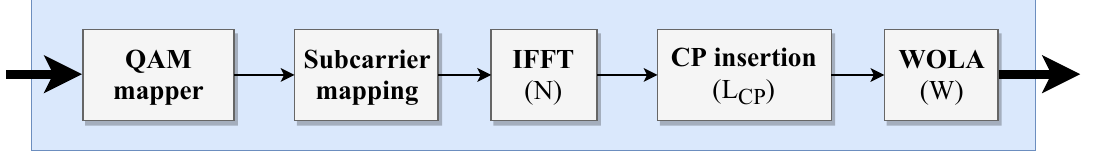
Figure 1. Datapath structure for OFDM baseband modulation.